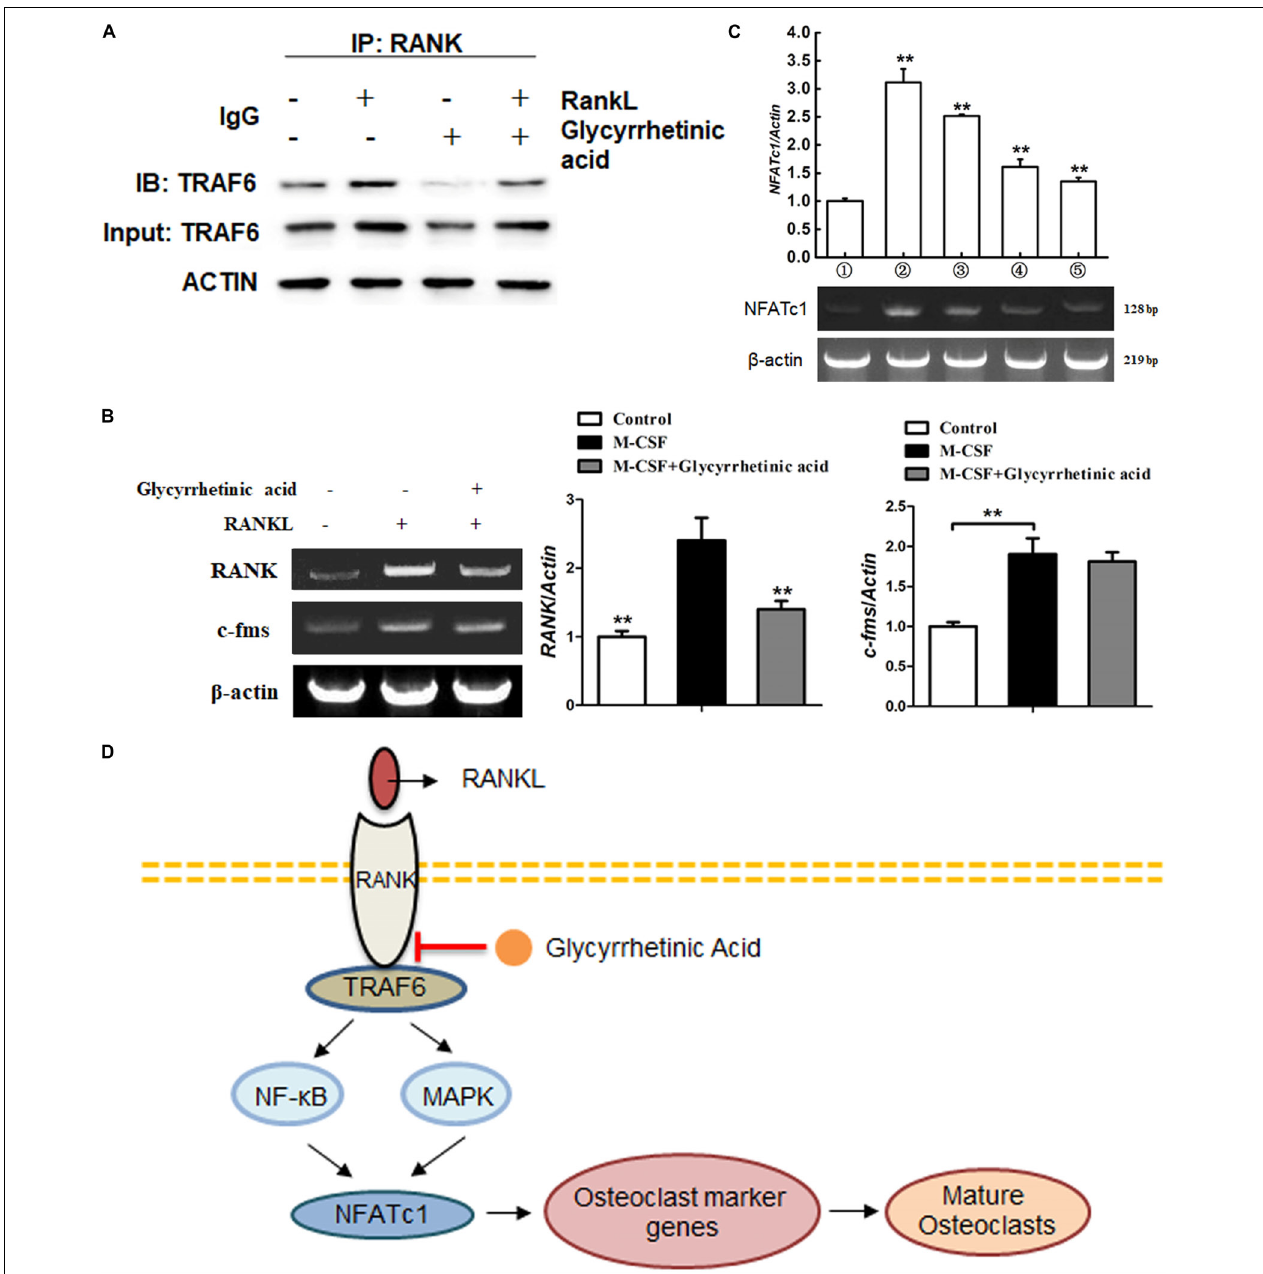
FIGURE 6 | 18 β -GA inhibits the activation of NFATc1 on osteoclastogenesis. (A) 18 β -GA suppresses the binding of RANK and TRAF6. (B) 18 β -GA had no significant effects on the expression of c-Fms mediated by M-CSF. However, the RANK expression was decreased by 18 β -GA. (C) 18 β -GA inhibits the mRNA levels of NFATc1. (D) 18 β -GA inhibits osteoclastogenesis through NF- κ B pathway and MAPK pathway of RANKL signaling.